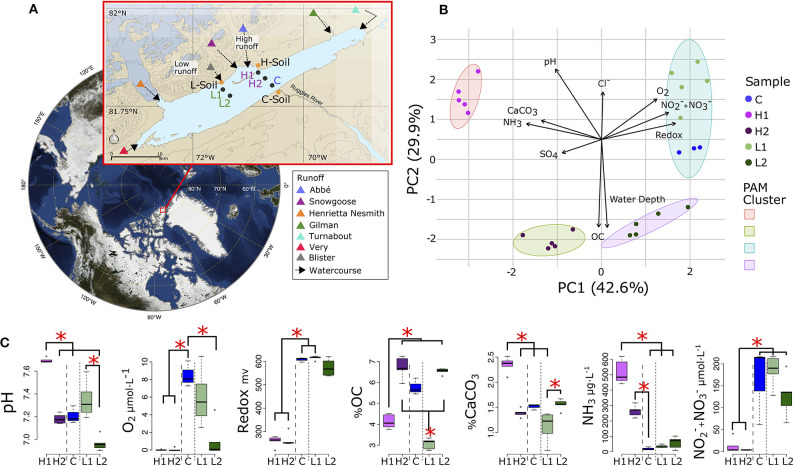
Lake Hazen sampling design and chemical composition. (A) Location of Lake Hazen (red box). Inset map: soil (orange dots) and sediment (black dots) sample sites are separated into hydrological regimes of high (purple), low (green), and negligible/control (blue) runoff. (B) Principal component analysis (PCA) showing the differences in physical and chemical composition of the sediment sites. Vectors display pH, dissolved dioxygen (O2), redox potential, nitrates and nitrites concentration (NO2- + NO3-), water depth, percent organic carbon (OC), percent calcium carbonate (CaCO3), sulfate (SO42-) concentration (SO4), and ammonia concentration (NH3). Individual points represent the mean values using 1 cm intervals measured in the top 5 cm. Partitioning around medoids was used to identify clusters. (C) Distribution of chemical features for sediment sites. Branches and asterisks indicate significant differences between sites P < 0.025 (Dunn Test). If branch tips form a dichotomy or trichotomy, the interactions within that group is not significant. Long dashes separate high runoff sites and dotted line separates low runoff sites. There was insufficient data to include soil sites in (B,C).